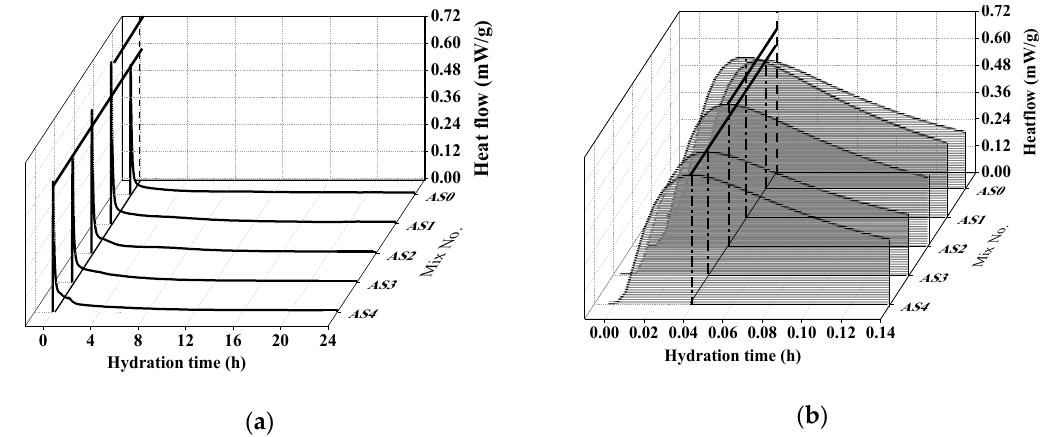
Figure 5. Effect of aluminum sulfate on the hydration heat flow: ( a ) 0–24 h, ( b ) 0–0.14 h.